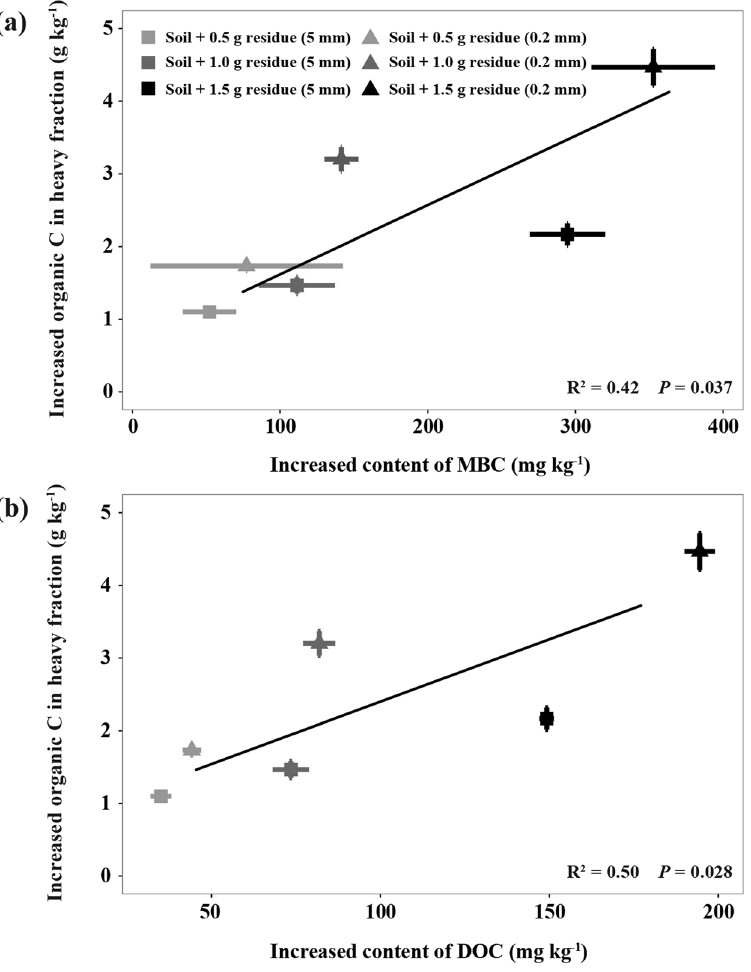
Figure 4. Relationships between the increased soil C in heavy fraction and the increased microbial biomass C ( a ) or the increased dissolved organic C ( b ) after incubation for 105